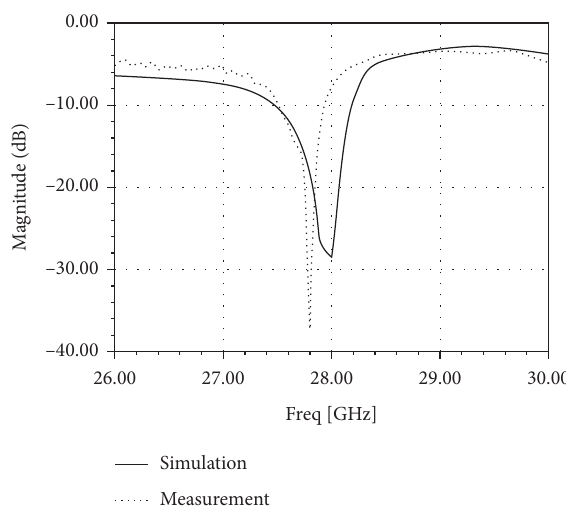
Figure 15: Comparison of simulation (solid line) and measure- ment (dotted line) return loss (S11) results.